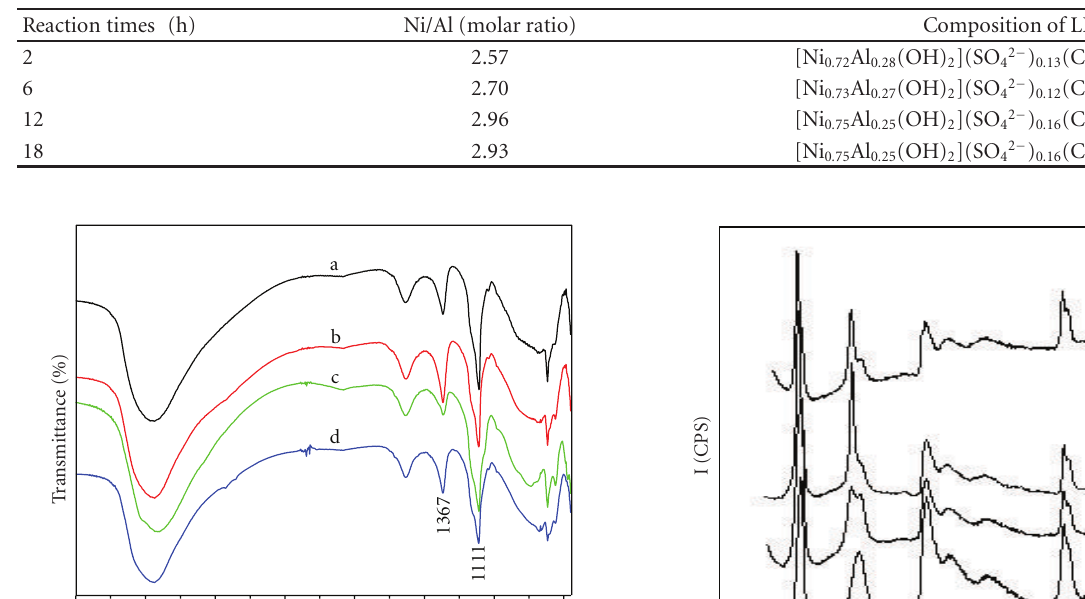
Figure 3: TEM images for Ni/Al LDHs synthesized at di ff erent pH values. (a) 5.5; (b) 8.5; (c) 10.0. Table 2: Chemical formulas of Ni/Al LDH prepared at di ff erent reaction times.